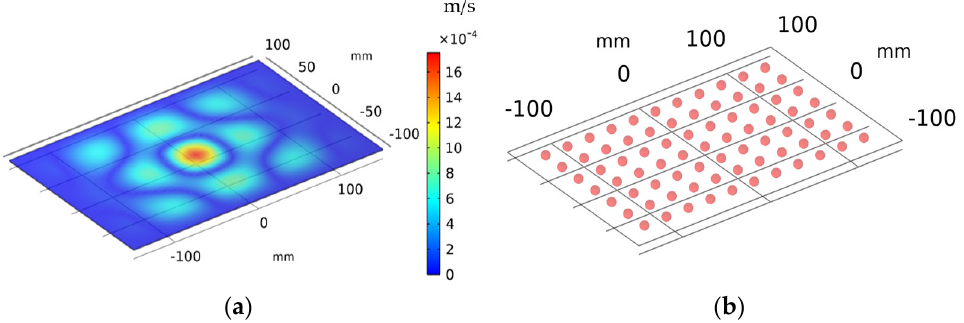
Figure 5. ( a ) Velocity magnitude over the plate at 1 kHz. ( b ) Grid of N = 77 points where the velocity data are evaluated.